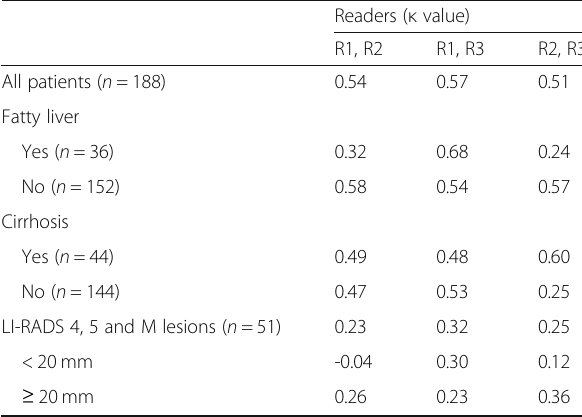
Table 5 Interobserver variability of aNC-MRI protocol ( κ